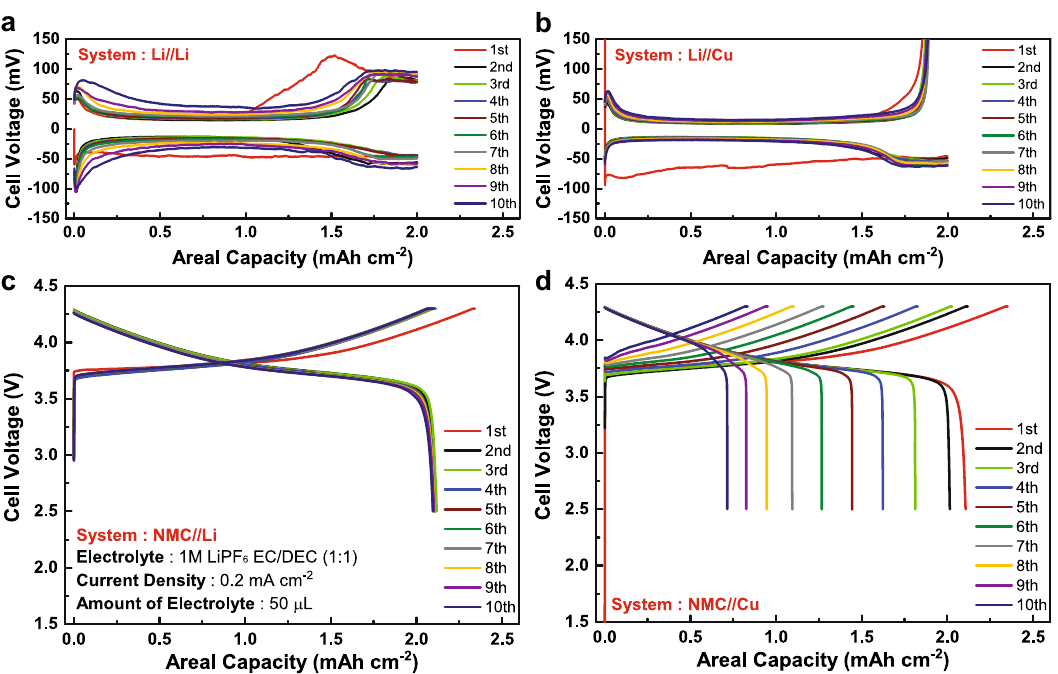
Fig. 2 Electrochemical charge and discharge curves. a Li/Li. b Li/Cu. c NMC/Li. d NMC/Cu. All the cells use 1 M LiPF 6 in EC:DEC (1:1) as electrolyte with the current density of 0.2 mA cm − 2 . We selected NMC-111 as the cathode material used in this electrolyte. One can substitute the desired cathode material for cathode study in cathode/Li cell and